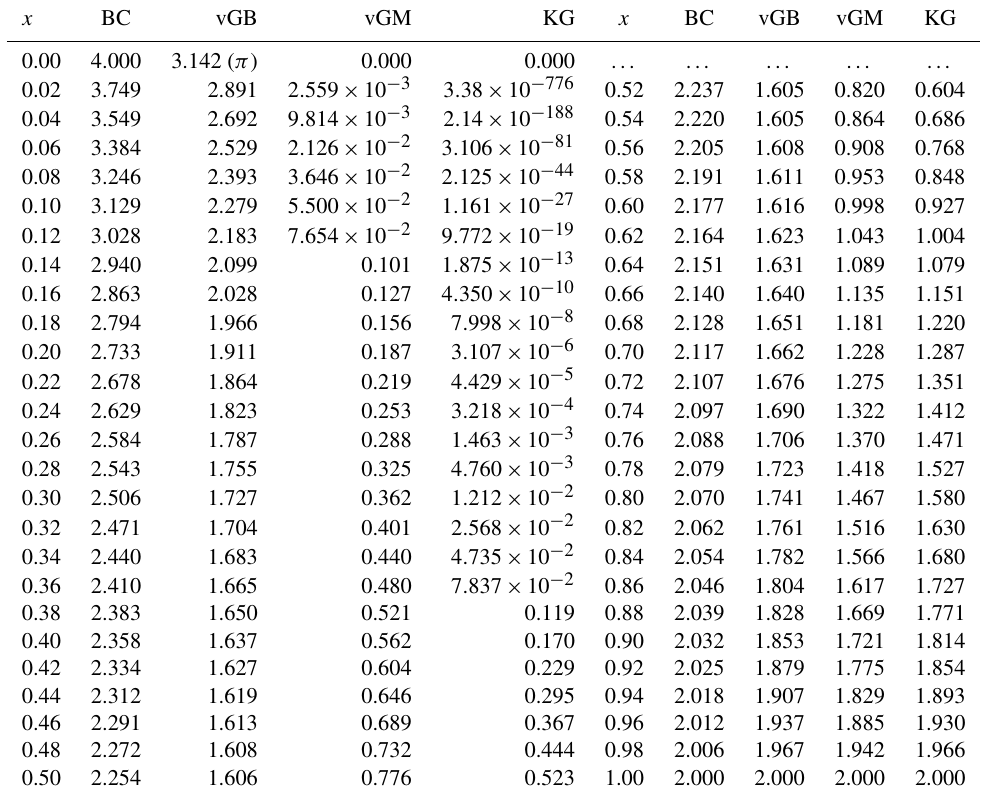
Table 1. Values of the square scaled sorptivity c p as a function of the shape index x for the studied hydraulic models: Brooks and Corey (BC), van Genuchten–Burdine (vGB), van Genuchten–Mualem (vGM), and Kosugi